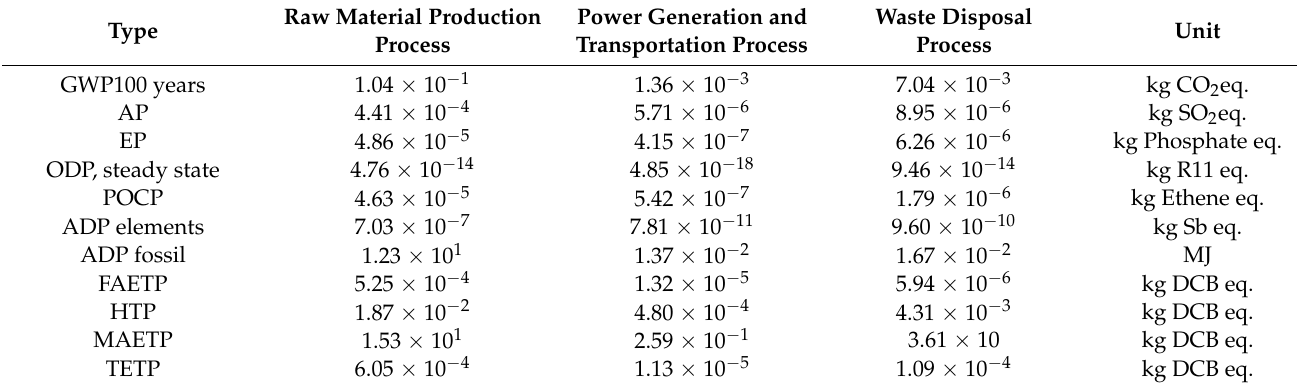
Table 5. LCA eigenvalue analysis results of photovoltaic power plants based on the CML2001 — Jan. 2016